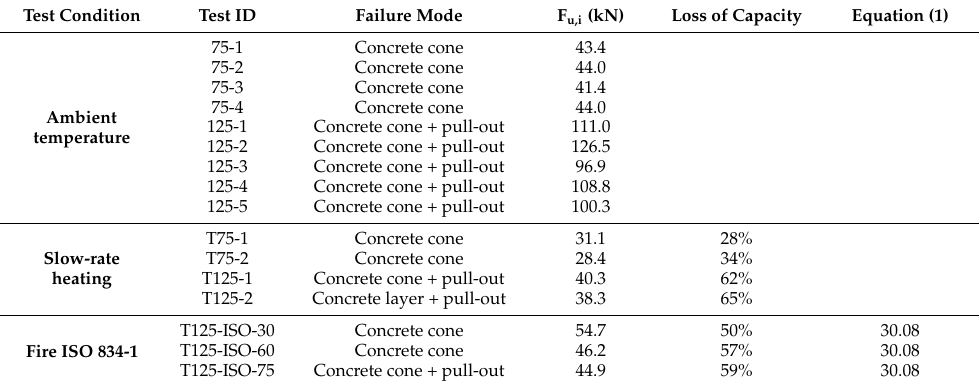
Table 4. Ultimate loads and loss of capacity due to